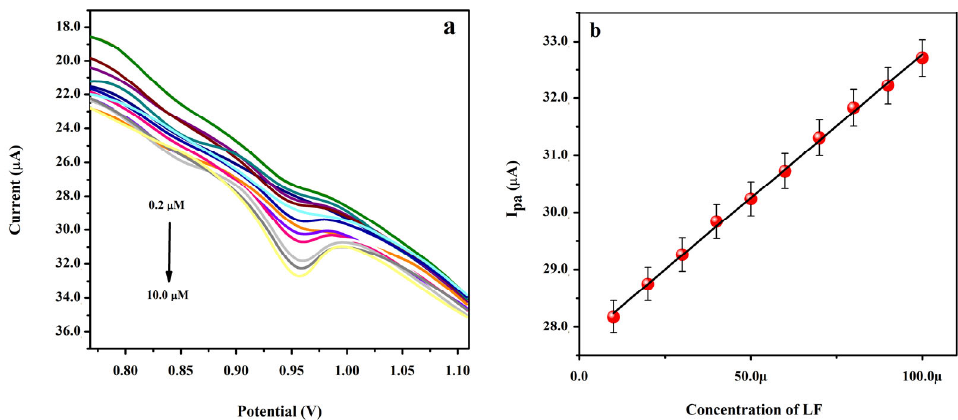
Figure 10. ( a ) Differential pulse voltammetry of LN with concentrations varying from 30.0 μ M to 90.0 μ M in 0.2 M phosphate buffer on EPGNLCPE measured at a 0.1 Vs − 1 scan rate.( b ) Plot of LN vs. I pa .